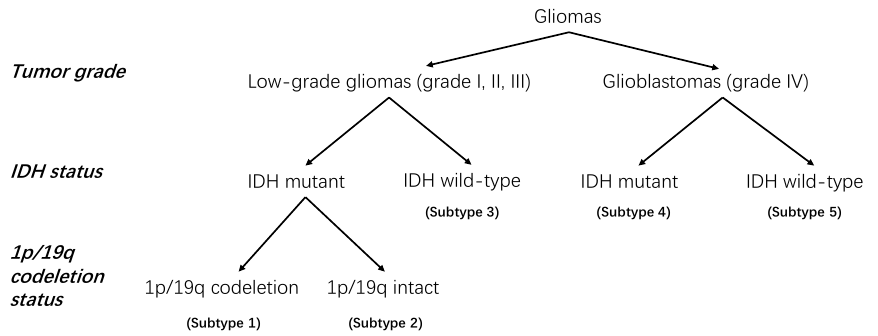
Figure 1. Classification of the glioma tumors used in this paper. This is a simplified version of the classification criteria of gliomas from the 2016 CNS WHO [2]. The subtype numbers 1 to 5 represent the five different glioma subtypes. They can be summarized, respectively, as subtypes “1—LGG, IDH mutant, 1p/19q codeleted”, “2—LGG, IDH mutant, 1p/19q intact”, “3—LGG, IDH wild type”, “4—GBM, IDH mutant”, and “5—GBM, IDH wild